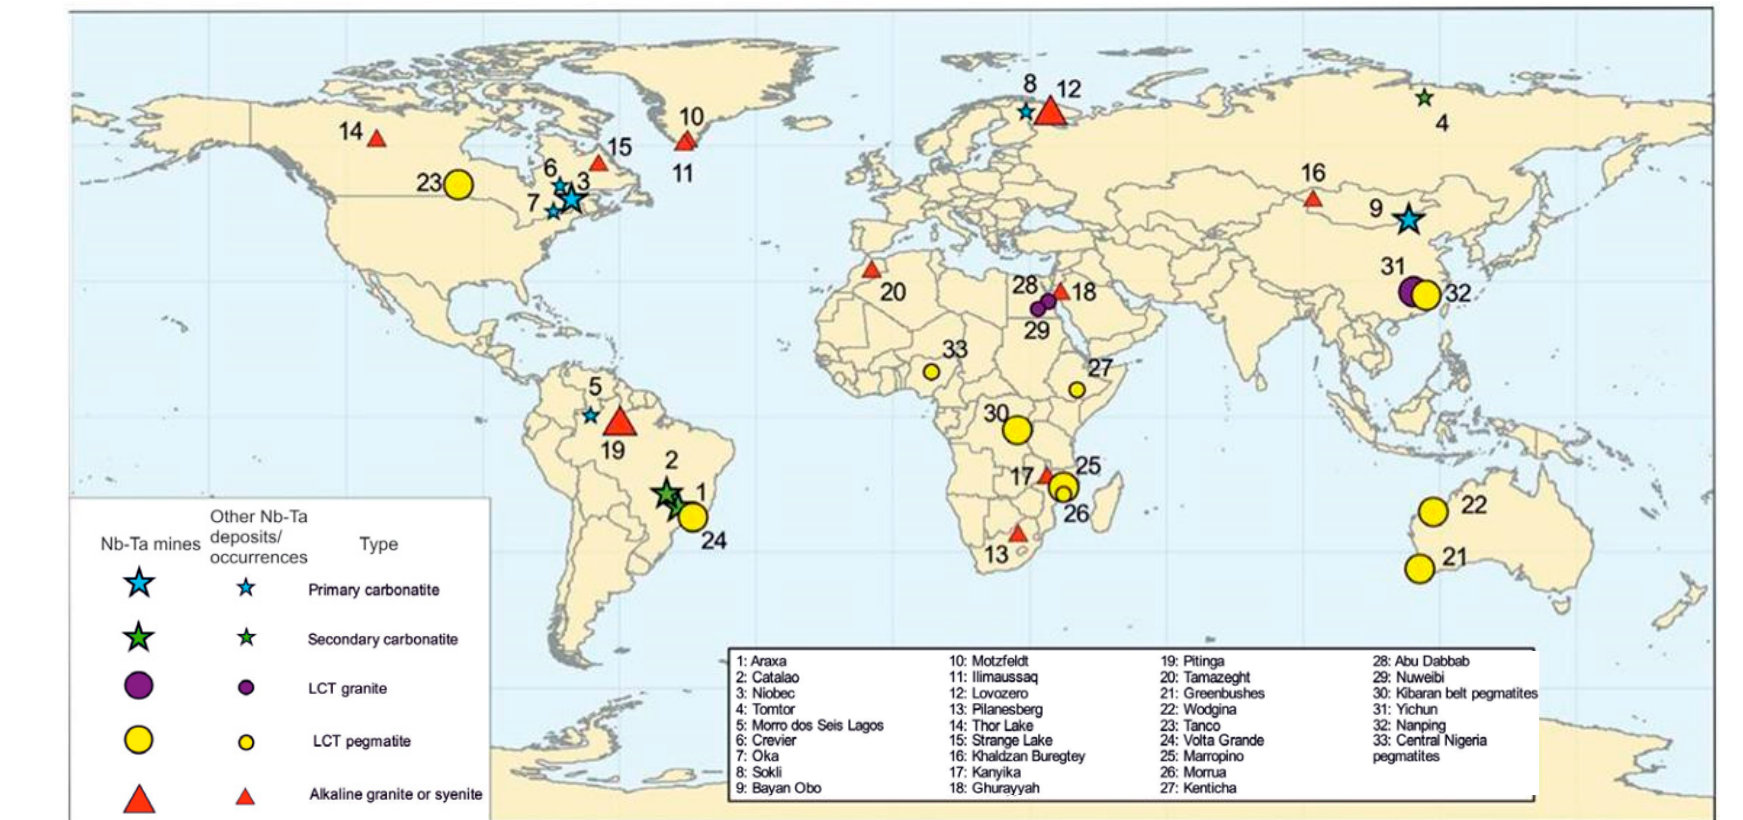
Figure 1. Distribution of various types of Nb-Ta deposits worldwide [13].